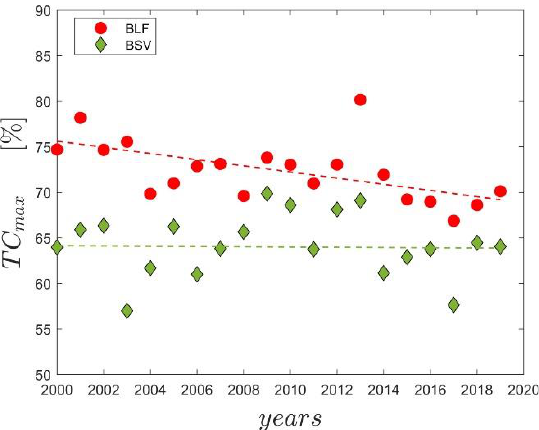
Figure 6. Maximum tree cover ( TC max ) over time for BLF (red marker) and BSV (green marker). The red and the green dotted lines are the trend lines estimated by means of the Theil-Sen for BLF and BSV,